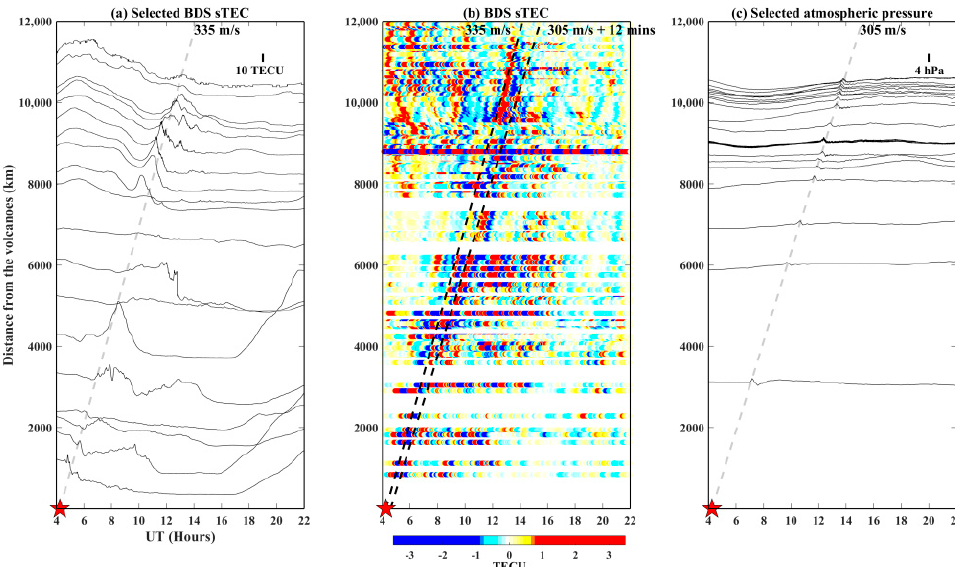
Figure 2. Variations in the BDS sTEC and air pressure associated with the underwater volcano eruption during 04:00 UT–22:00 UT on 15 January 2022: ( a ) Variations in the BDS sTEC from 19 selected IPPs with a distance of 0–12,000 km away from the volcano. ( b ) Spatiotemporal distribution of the TEC perturbations. The BDS sTEC is processed with a removal of a 1 h running average. ( c ) Variations in the air pressure from the 26 barometers. The red star indicates occurrence of the volcano eruption. The dashed lines show arrival times of the waves propagating away from the volcanoes, which are estimated by utilizing the speed and delay time as written above.